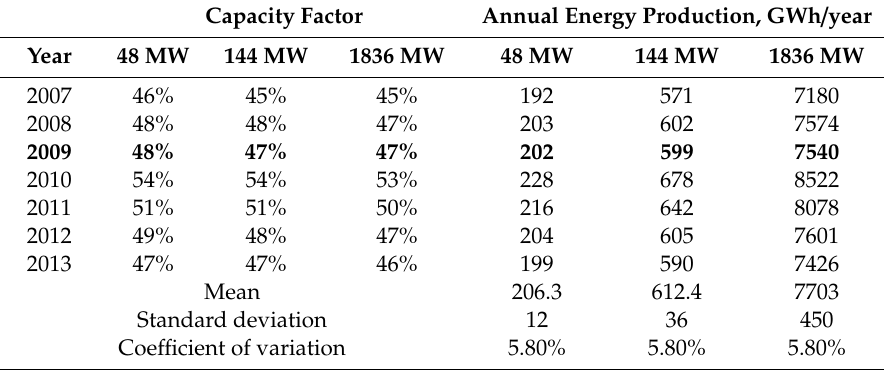
Table 5. Annual energy production for three wind farm scenarios. Median wind speed year bolded.